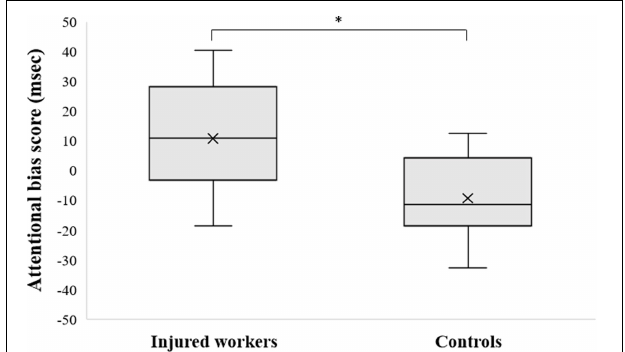
FIGURE 1 | Attentional Bias score (AB) values (msec) in Injured Workers and Controls. Cross represents the mean value, central band represent the median, bottom and top of the box represent the first and third quartile respectively, whiskers reflect the minimum and maximum of all the data. ∗ p <